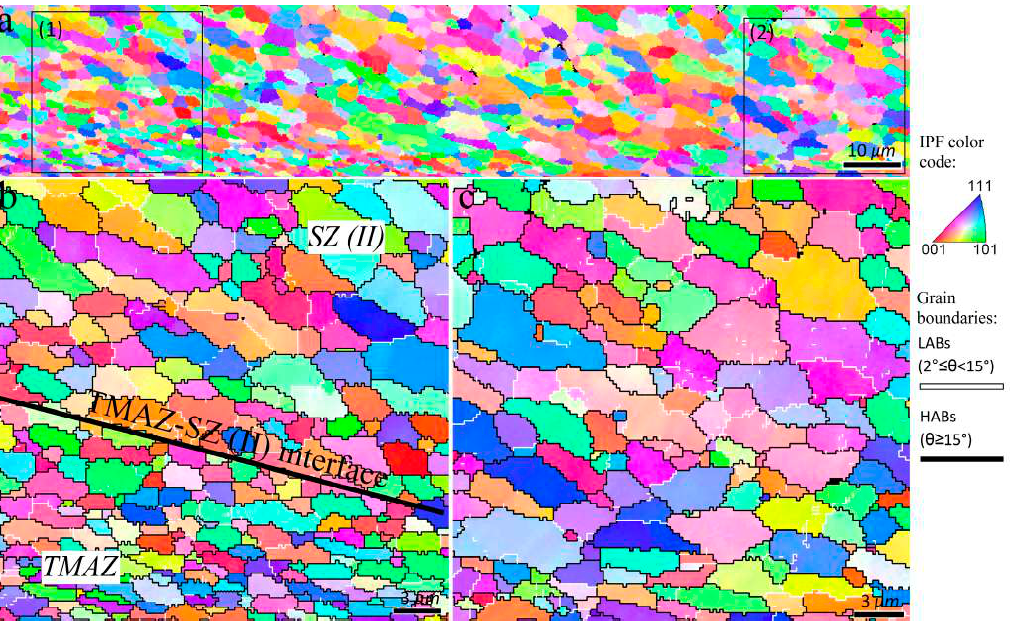
Figure 8. Inverse pole figure maps of the area indicated by rectangle 1 in Figure 7. Higher magnified views of zones 1 and 2 indicated in ( a ) are illustrated in ( b ) TMAZ and ( c ) interfacial area between TMAZ and SZ-II, respectively.